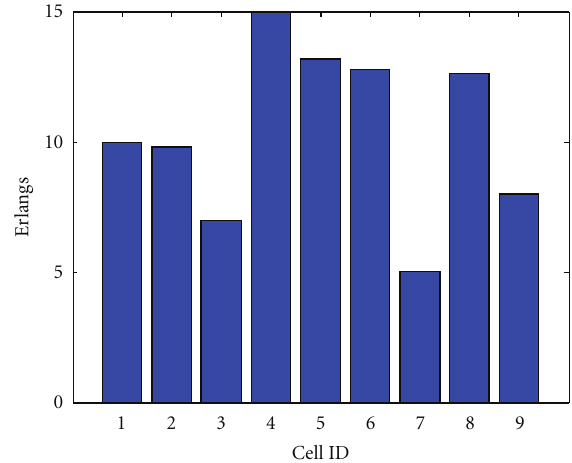
Figure 14: Final load handled by the femtocells (no. of FBSs = 9). Table 2: Fixed and optimized power network performance. Mean value